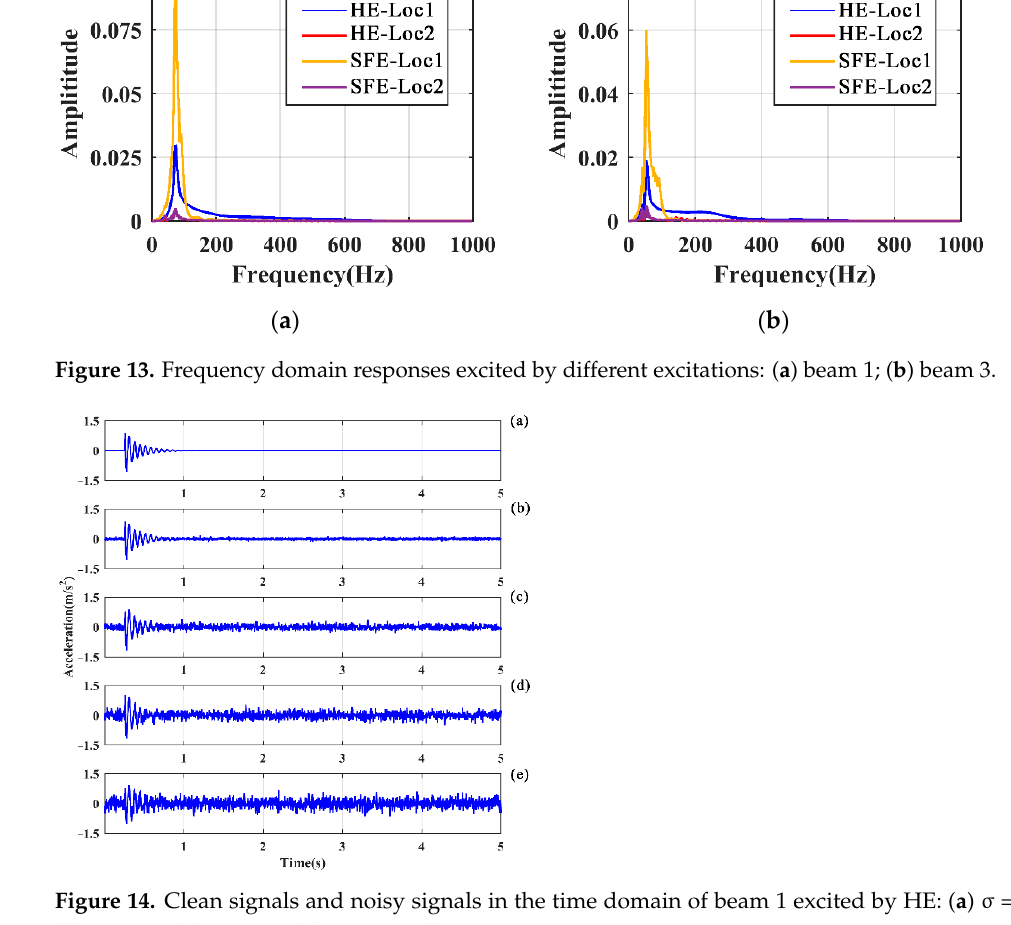
Figure 14. Clean signals and noisy signals in the time domain of beam 1 excited by HE: ( a ) σ = 0; ( b ) σ = 0.05; ( c ) σ = 0.10; ( d ) σ = 0.15; ( e ) σ = 0.20.